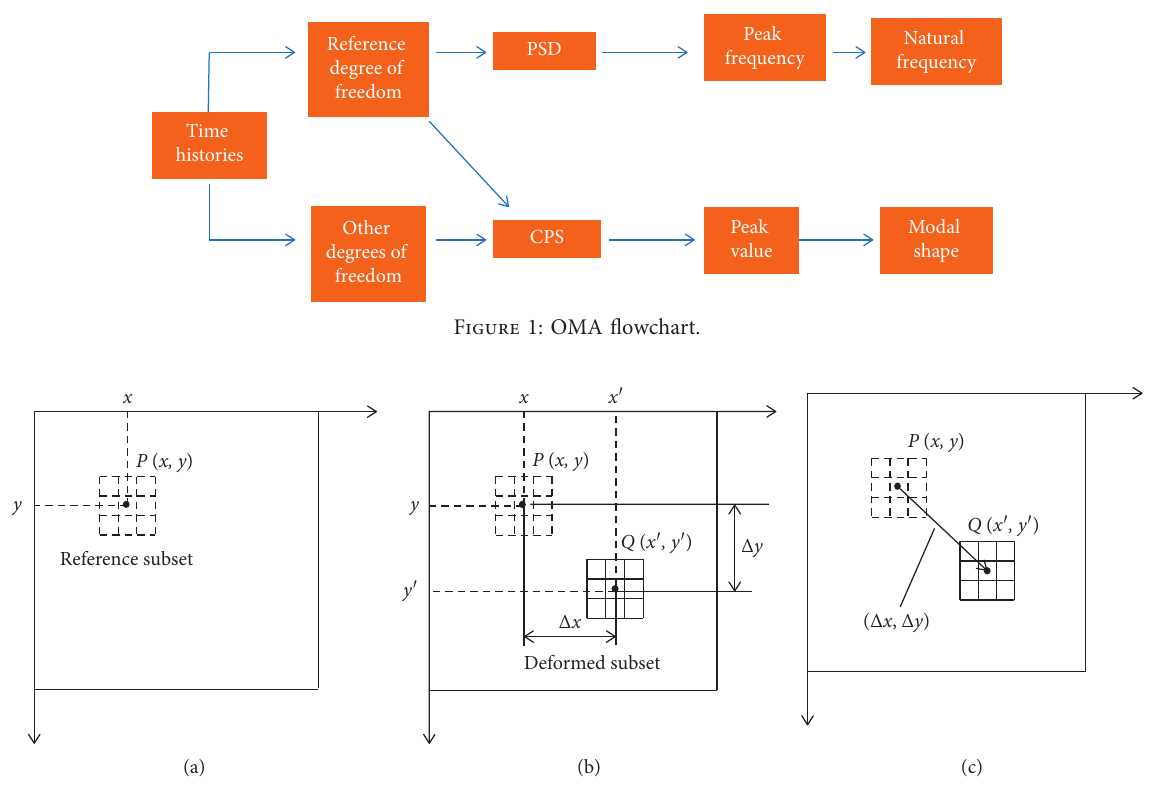
Figure 2: Tracking point movement by the DIC method. (a) Reference image. (b) Deformed image. (c) Displacement of the subset.